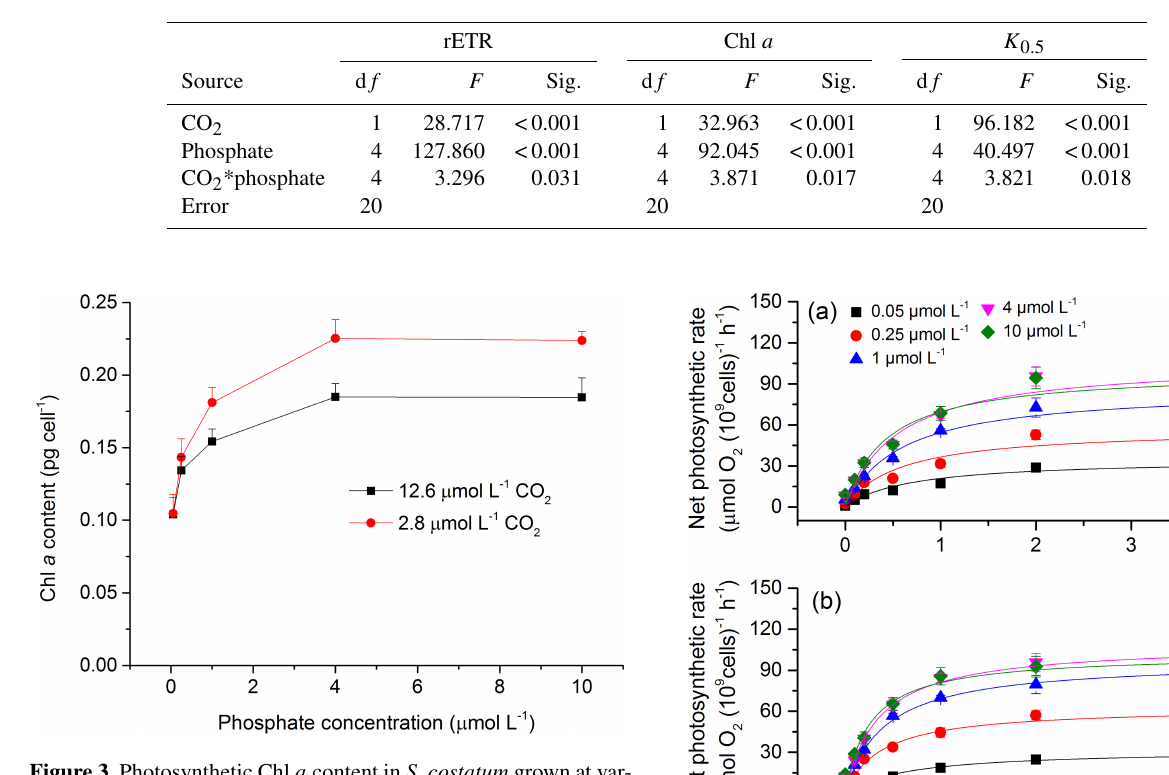
Table 2. Two-way analysis of variance for the effects of CO 2 and phosphate on relative electron transport rate (rETR), Chl a , and CO 2 level required to obtain half of the DIC-saturated maximum rate of photosynthetic O 2 evolution ( K 0 . 5 ) of S. costatum . CO 2 *phosphate means the interactive effect of CO 2 and phosphate, d f means degree of freedom, F means the value of the F statistic, and Sig. means the p value.